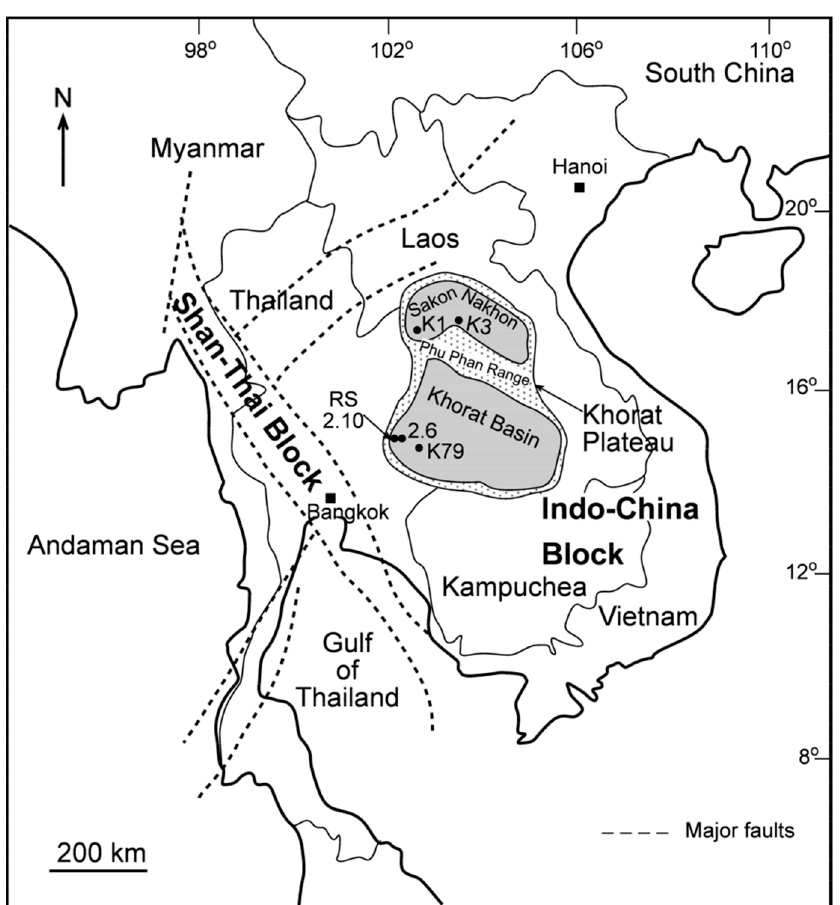
Figure 1. Geological map of Southeast Asia showing the Khorat Plateau, the Khorat Basin (cores RS2.10, RS2.6, and K79) and the Sakon Nakhon Basin (cores K1 and K3), major faults, and tectonic blocks (modified from El Tabakh et al. [24]).